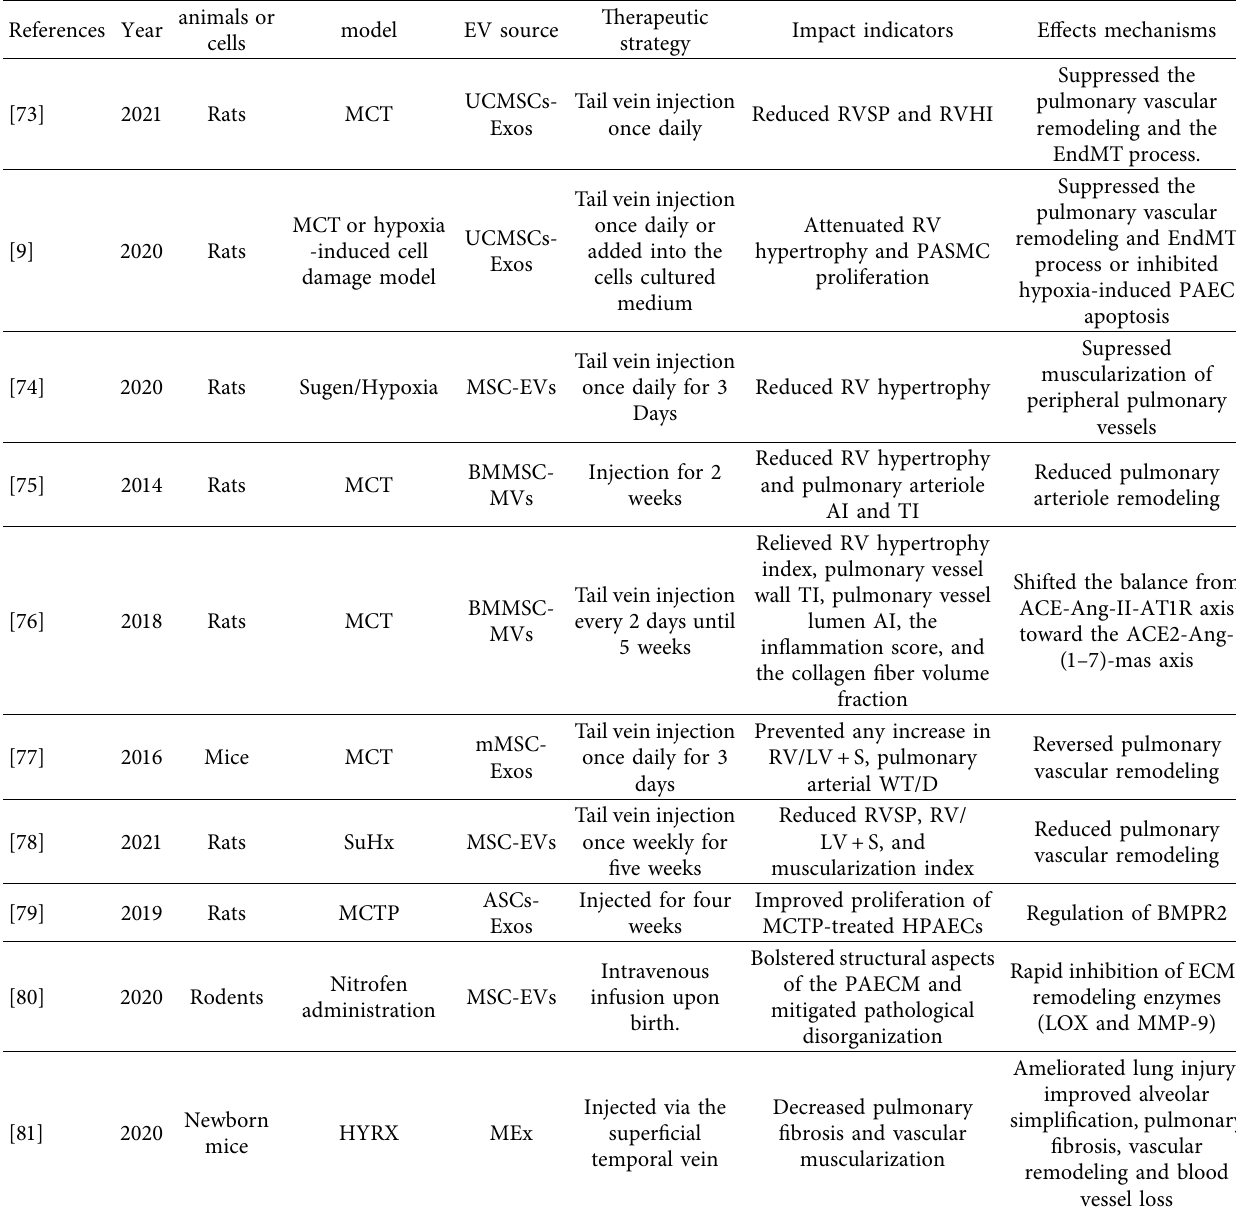
Table 1: Te efects of MSC-EVs against experimental